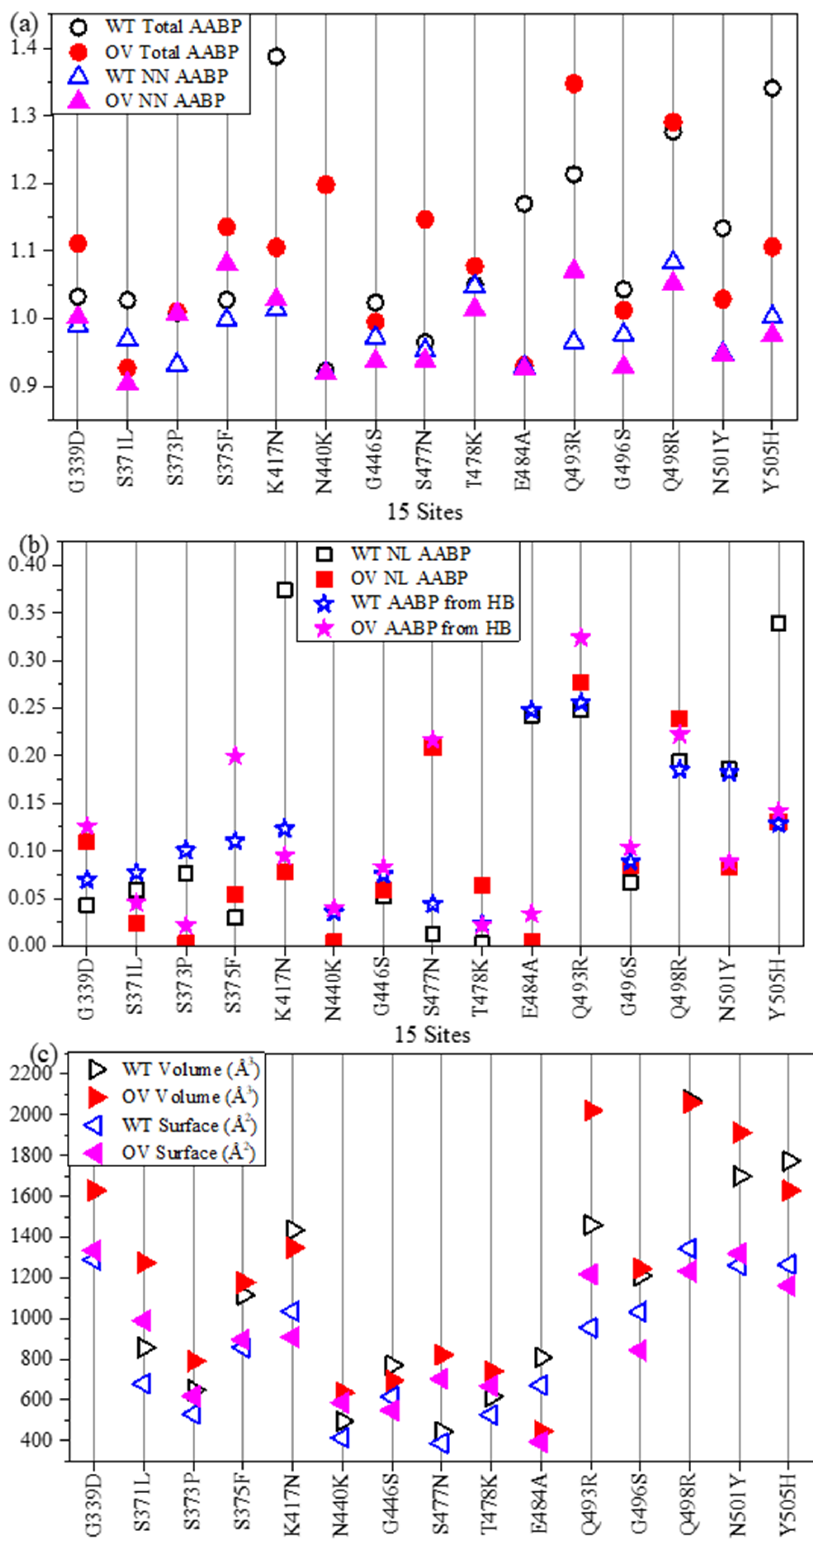
Figure 6. Comparison of 15 OV mutations with their corresponding WT sites of RBD-ACE2 complex in term of ( a ) Total AABP and NN AABP, ( b ) NL AABP and AABP from HB, and ( c ) volume and surface for WT and OV.